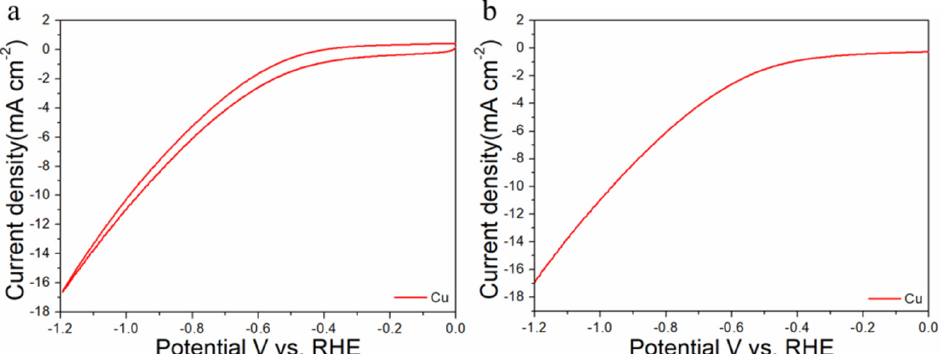
Figure 10. Cyclic voltammograms ( a ) and linear scan voltammograms ( b ) of Cu/C in CO 2 -satruated 0.1 M KHCO 3 solution collected at a scan rate of 20 mV s − 1 .